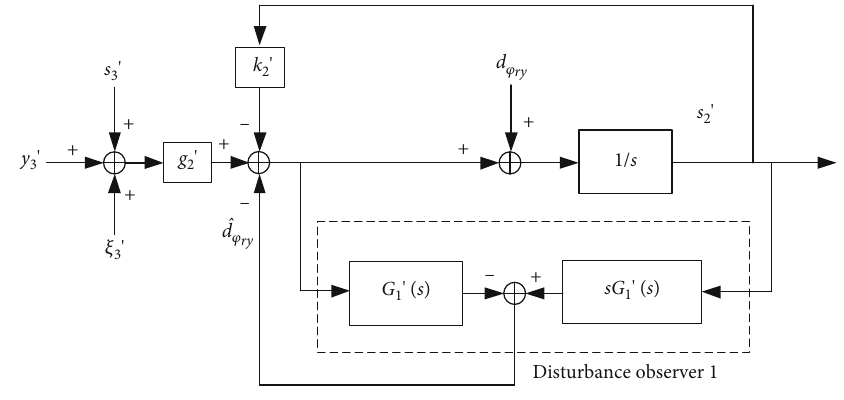
Figure 2: Disturbance observer for estimating d